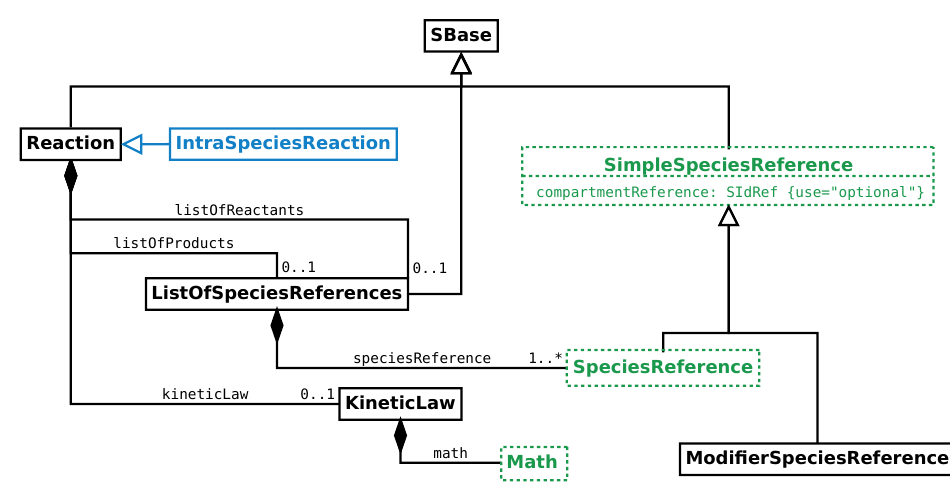
Figure 14: The changes under the Reaction class including IntraSpeciesReaction , SimpleSpeciesReference , Species- Reference and Math